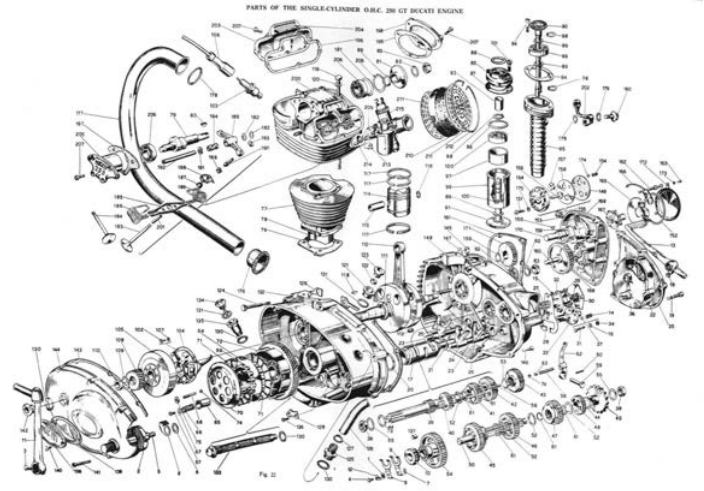
Figure 1. Ducati 250 GT Engine,